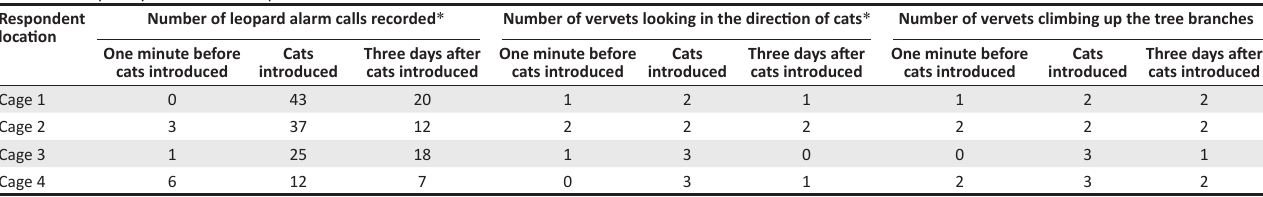
TABLE 1: Frequency of recorded responses of the vervets. Respondent